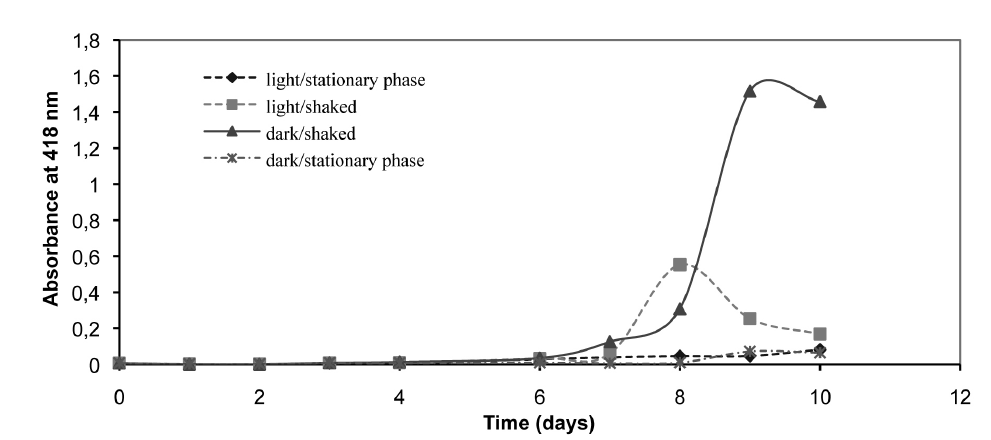
Figure 1. Time course of laccase production by Fomitiporia mediterranea.